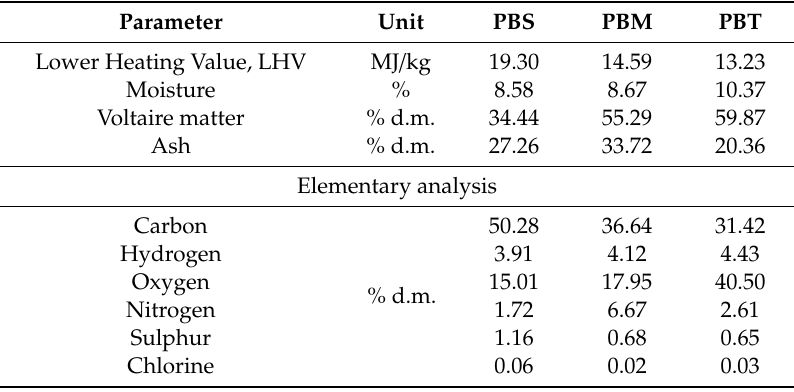
Table 1. Energy properties of fuels from sewage